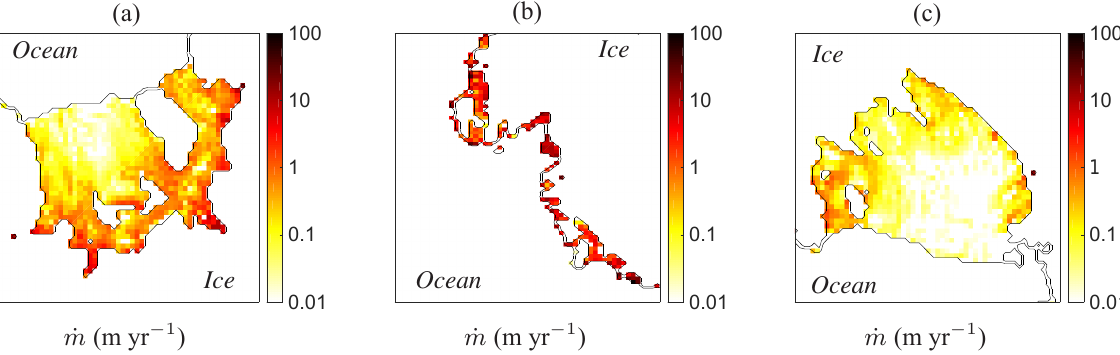
Figure 10. As Fig. 9a, but with a logarithmic colour scale (negative and zero values shown white) and zoomed in on (a) Filcher–Ronne Ice Shelf (group 1), (b) West Antarctica including Pine Island and Thwaites (group 11) and (c) Ross Ice Shelf (group